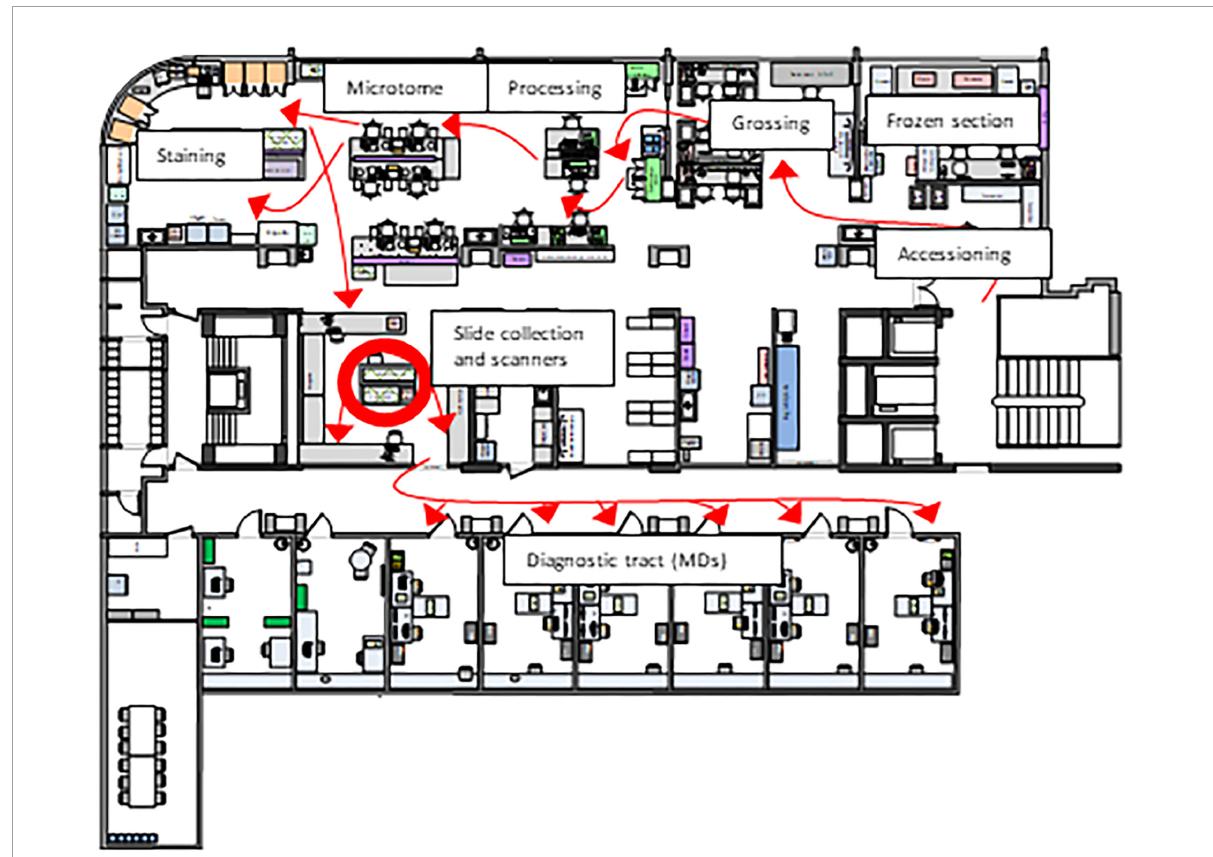
FIGURE1 Layout of our histology laboratory according to Lean principles. The red arrows that represent the path taken by a specimen from acquisition to the MD are unidirectional (“LEAN biopsy/resection street”). Therefore, the Lean solution was to place scanners in the slide sorting area (red circle), which minimizes waste both for a hybrid solution (digital and conventional sign-out) and fully digital sign-out.